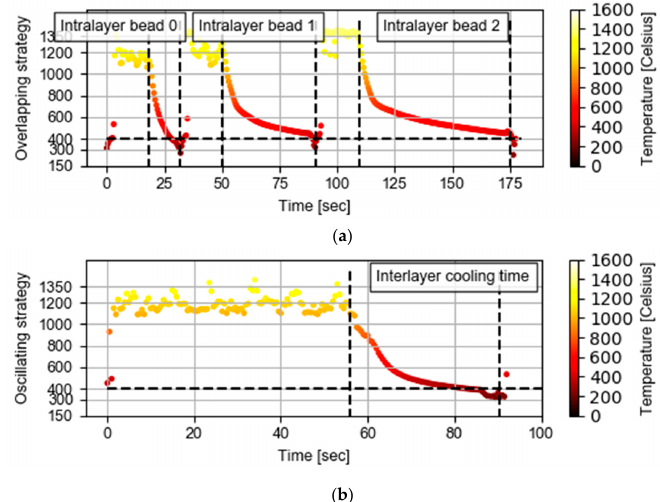
Figure 12. Temperature at the surface of the wall during one layer deposited in ( a ) overlapping strategy and ( b ) oscillating strategy.